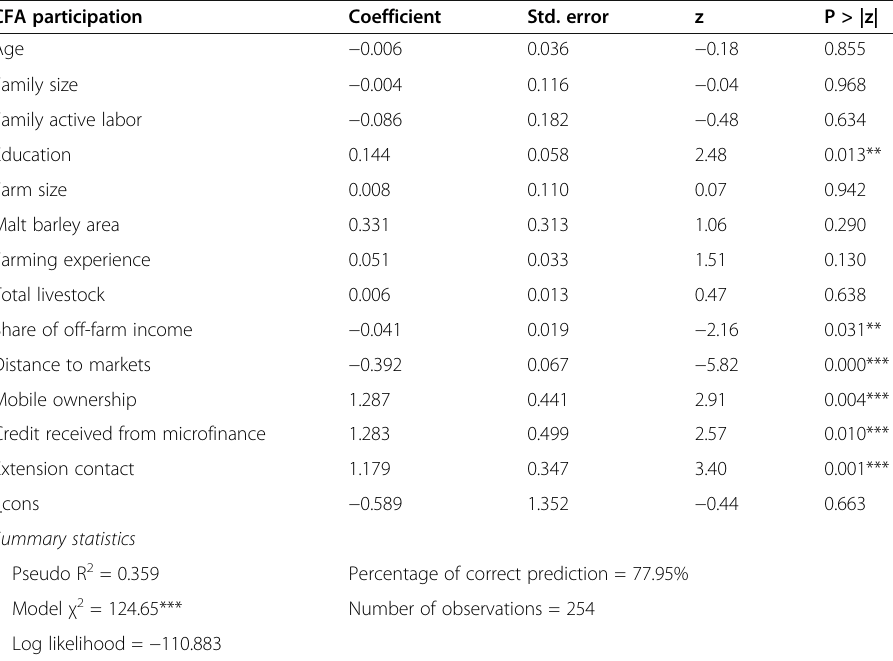
Summary statistics Pseudo R 2 =